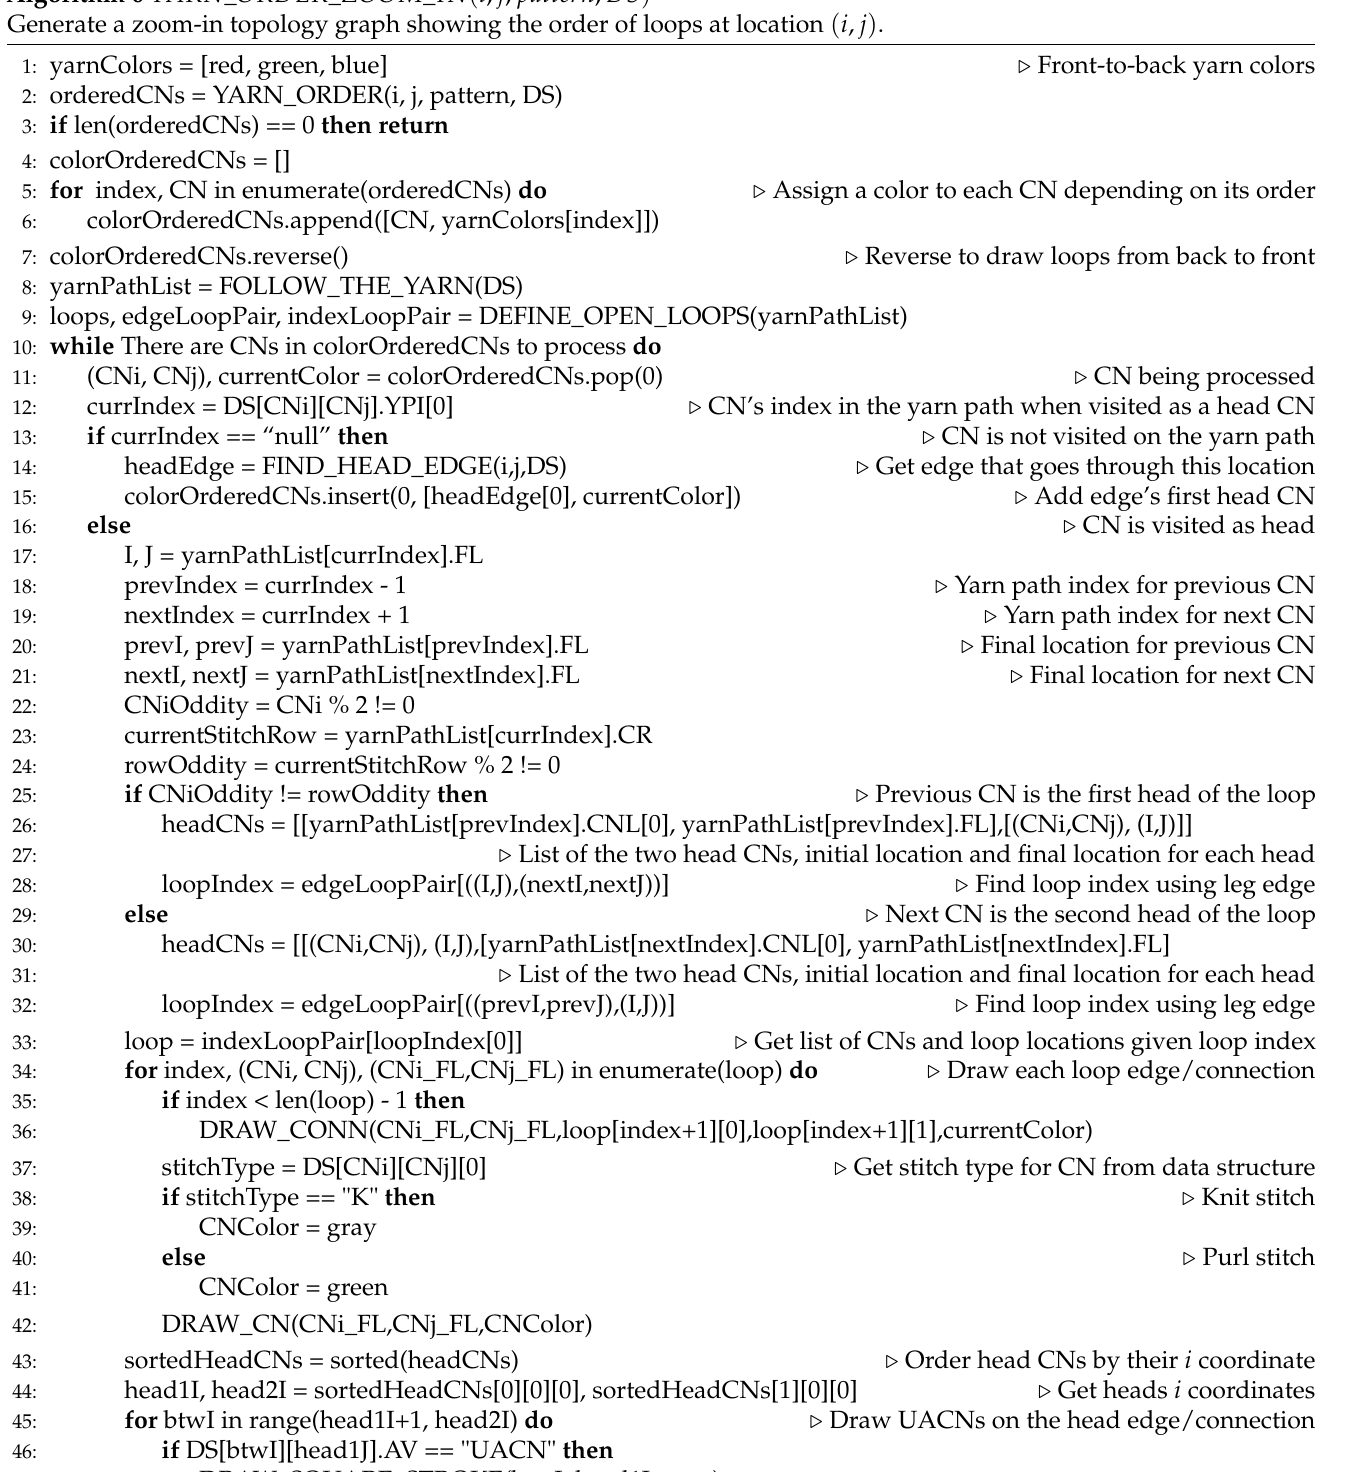
Algorithm 6 YARN _ ORDER _ ZOOM _ IN ( i , j , pattern , DS ) Generate a zoom-in topology graph showing the order of loops at location ( i , j )